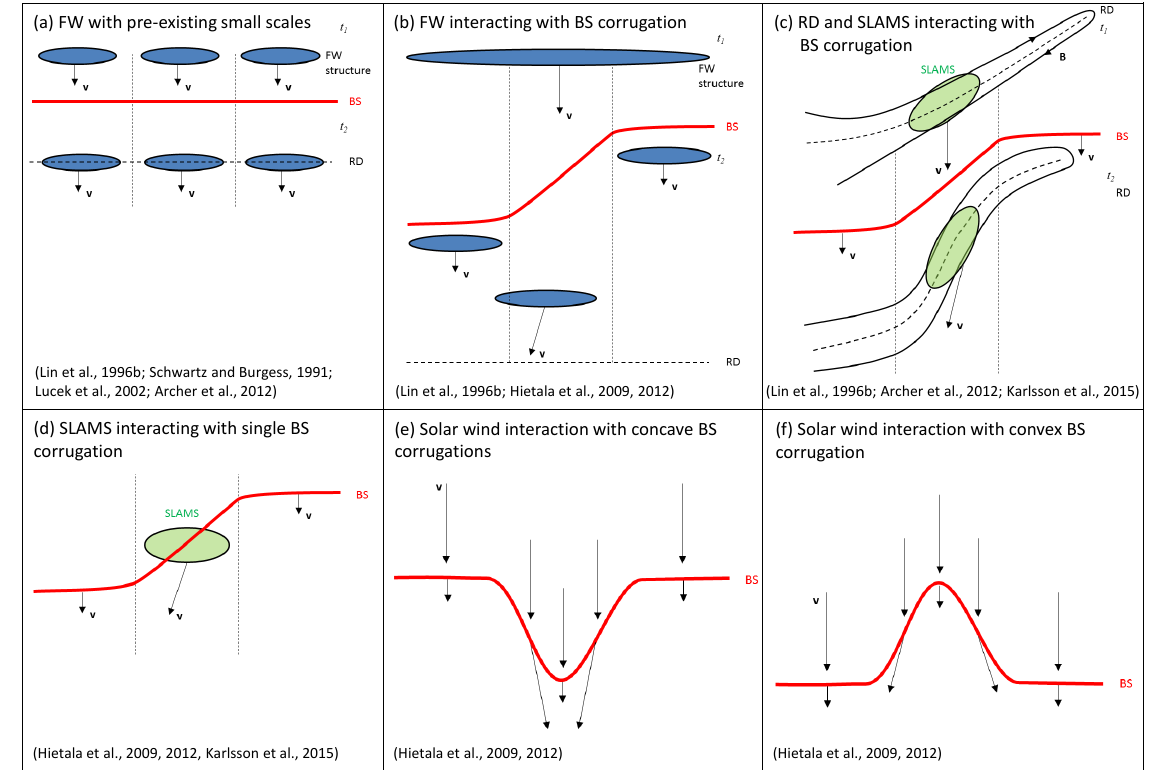
Figure 13. Six different scenarios for formation of the jets in this paper. FW = fast wave, BS = bow shock, RD = rotational discontinuity; t 1 and t 2 refers to different times. For each scenario the most relevant references are indicated in the respective